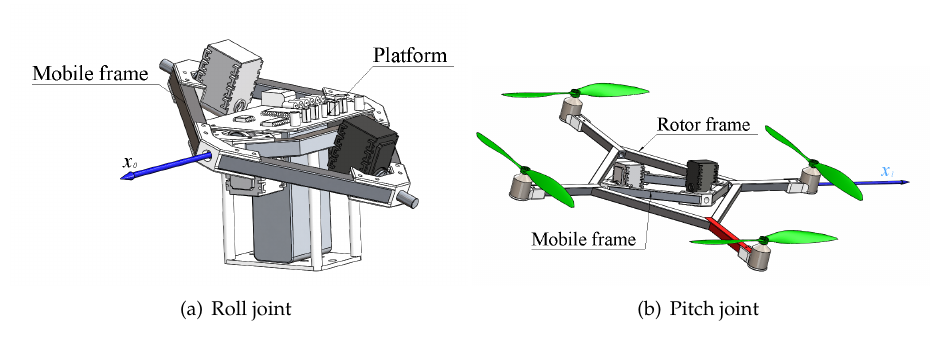
Figure 1. Roll joint axis ( a ), pitch joint axis ( b